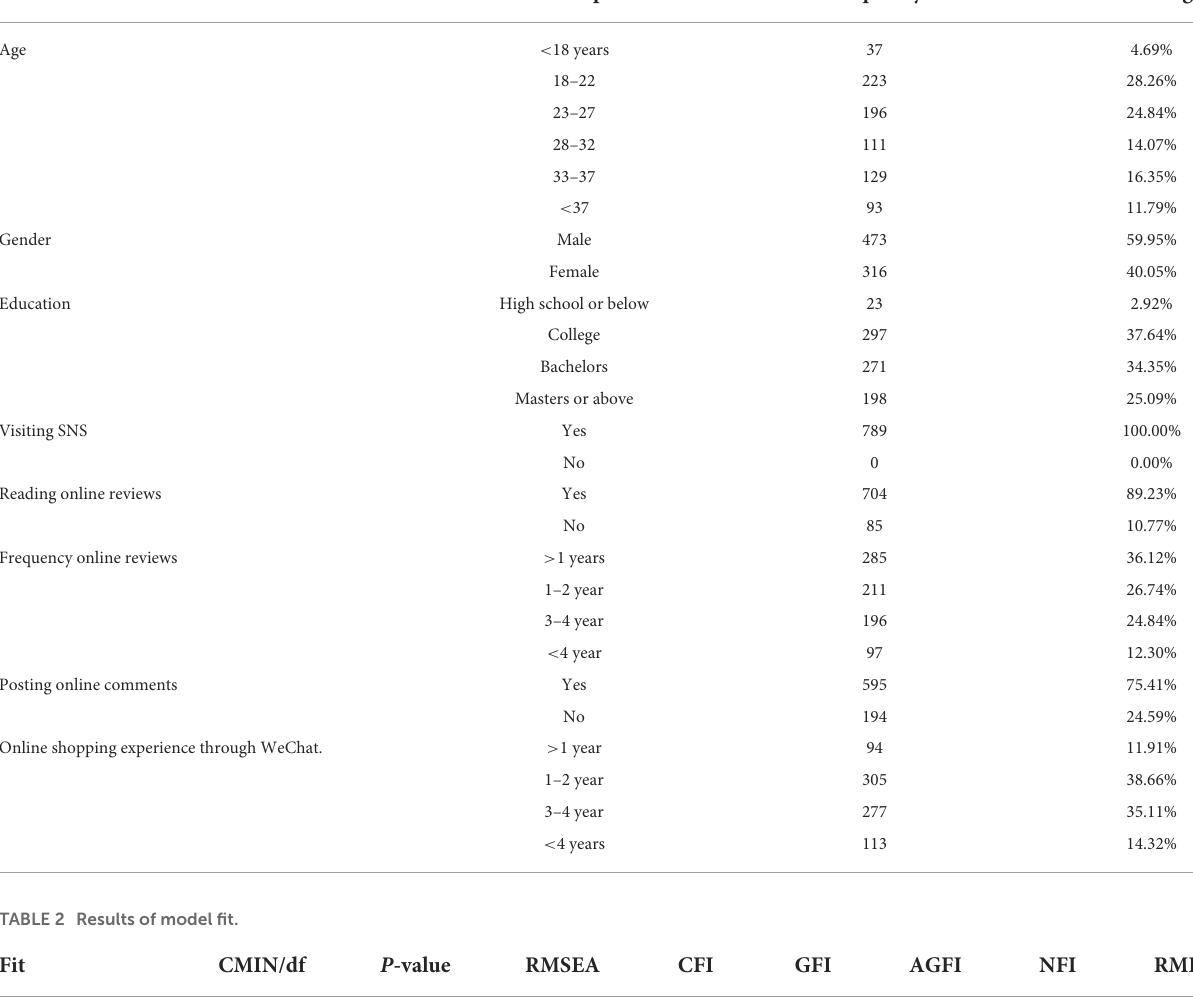
TABLE 1 Demographics of research sample ( N = 789).